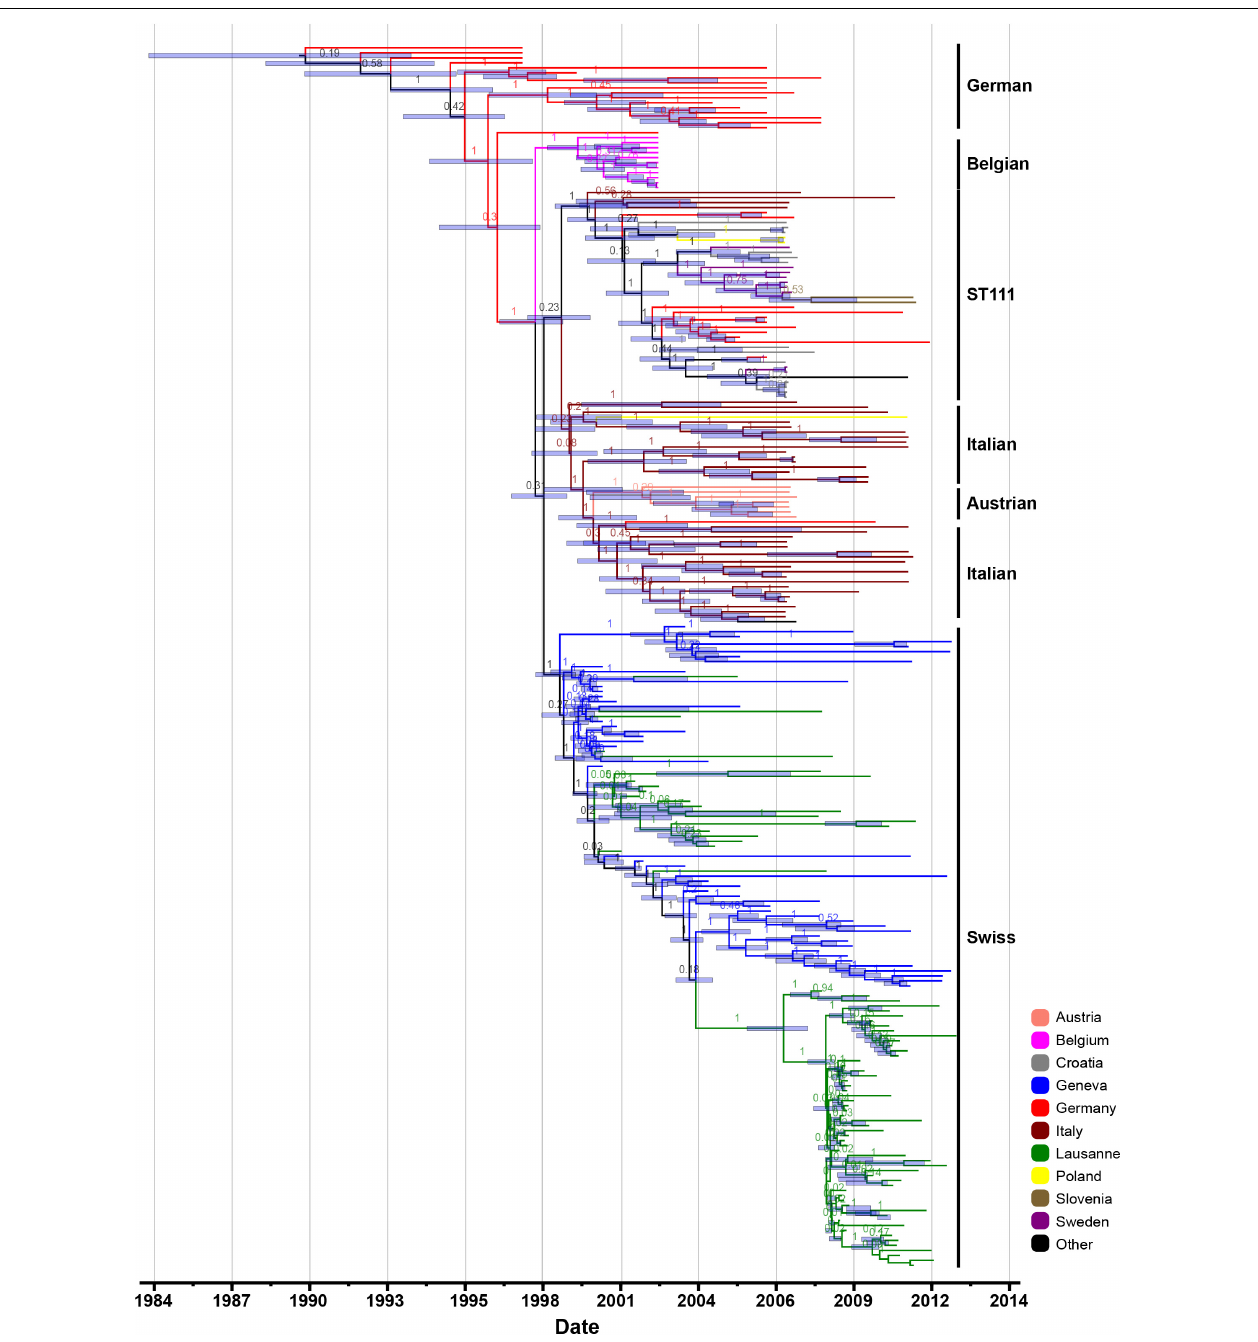
FIGURE 2 | Maximum clade credibility (MCC) tree. Maximum clade credibility Bayesian phylogenetic tree reconstruction of the selected subset of 245 MRSA ST228 and ST111 MRSA genomes that were collected between 1993 and 2012. Tips of the tree are embarrassed by isolation dates; the time scale is shown at the base of the tree and countries/cities of origin are highlighted in different